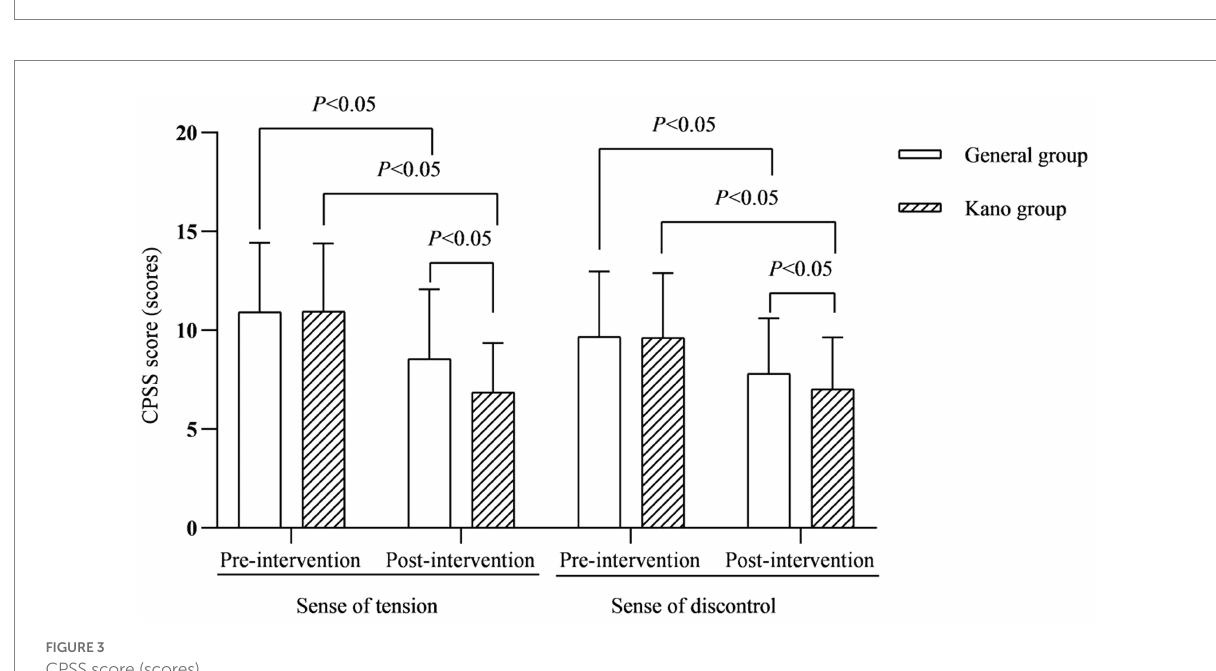
FIGURE 2 Psycho-behavioral indicators for children.